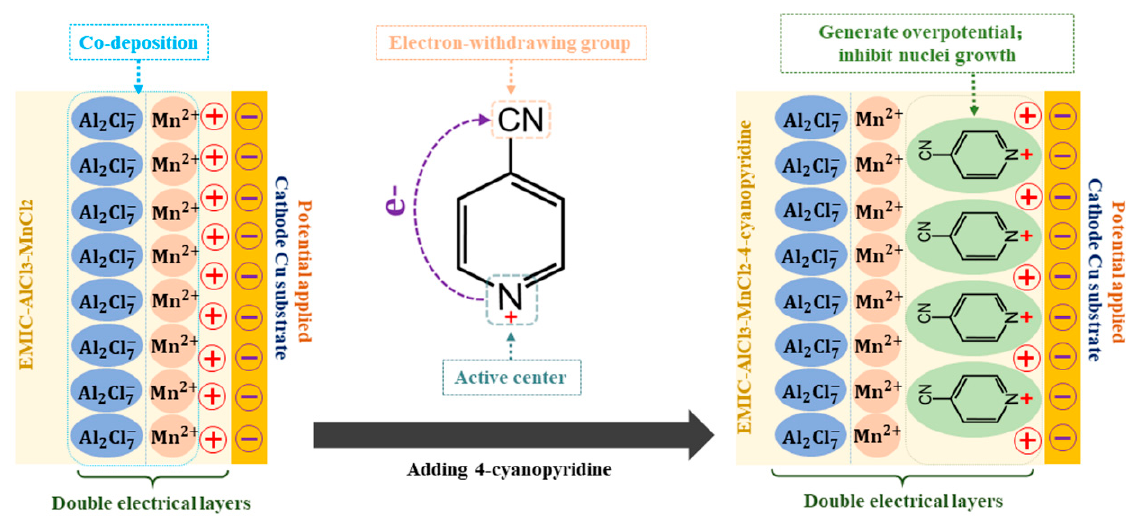
Figure 9. Schematic diagram of the mechanism of 4-cyanopyridine in EMIC-AlCl 3 -MnCl 2 ionic liquid.